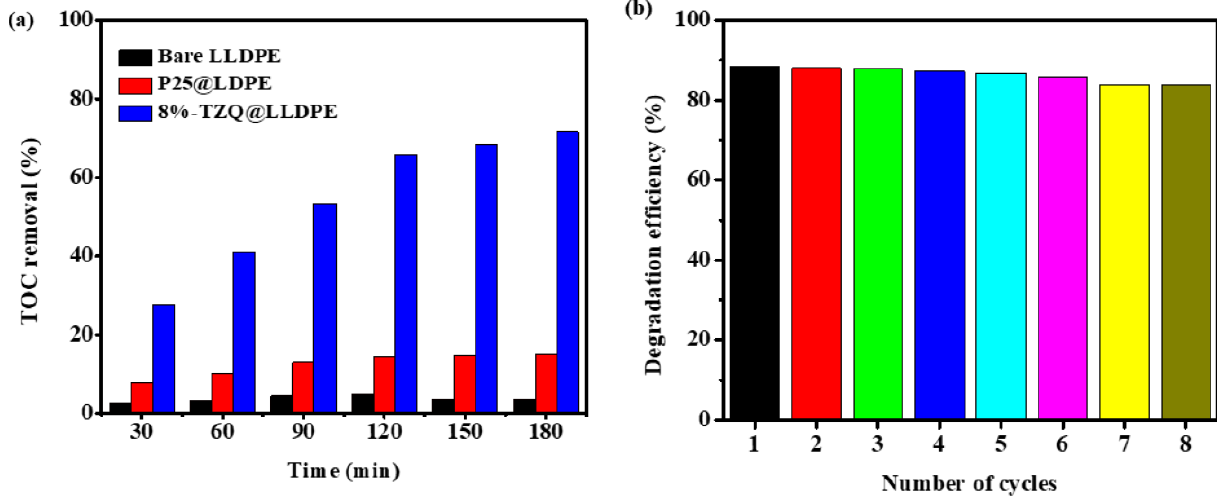
Figure 11. ( a ) Photocatalytic mineralization of TC for neat LLDPE and its hybrid system, and ( b ) recycled experiments utilizing 8%-ZT@LLDPE. Reprinted from [58].